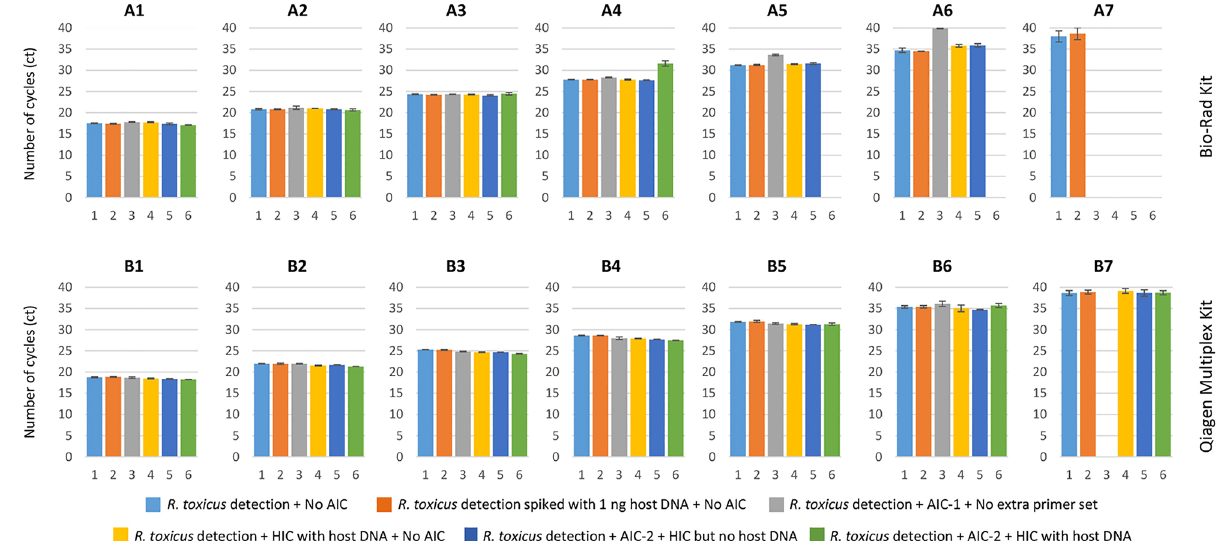
Figure 3. Comparative sensitivity assays to predict the detection limit of TaqMan qPCR-based assays with genomic and spiked DNA of Rathayibacter toxicus . A1–A7 are tenfold serial dilutions of genomic DNA from 1 ng to 1 fg and performed using Bio-Rad SsoFast Probes Supermix Kit; B1-B7 are genomic DNA dilutions from 1 ng to 1 fg and performed using Rotor-Gene Multiplex PCR Master Mix Kit. Standard deviation was calculated using three replicates of each reaction and each PCR assay was run with non-template negative control.